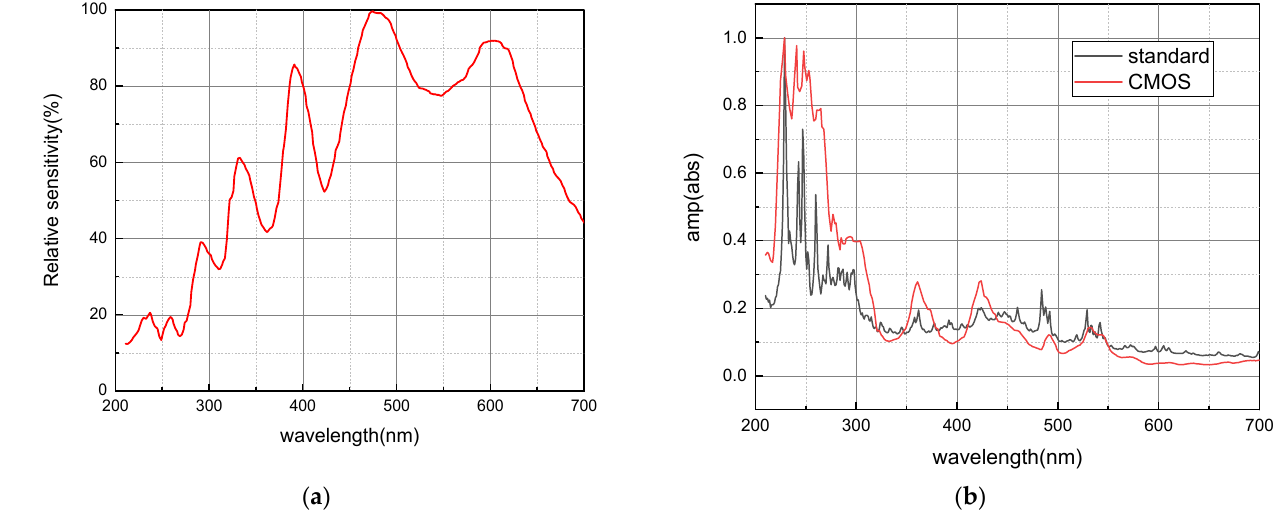
Figure 8. ( a ) CMOS sensor’s relative sensitivity. ( b ) Spectrum comparison of xenon lamp between standard dataset and the CMOS-based system.